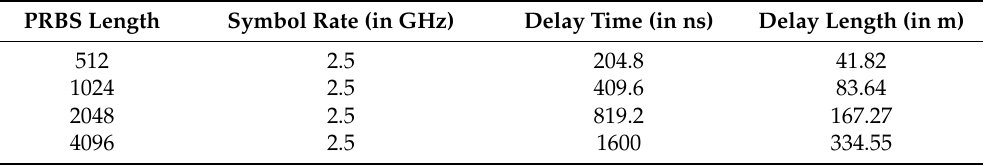
Table 2. Analysis of the required length of the delay lines for the PFS